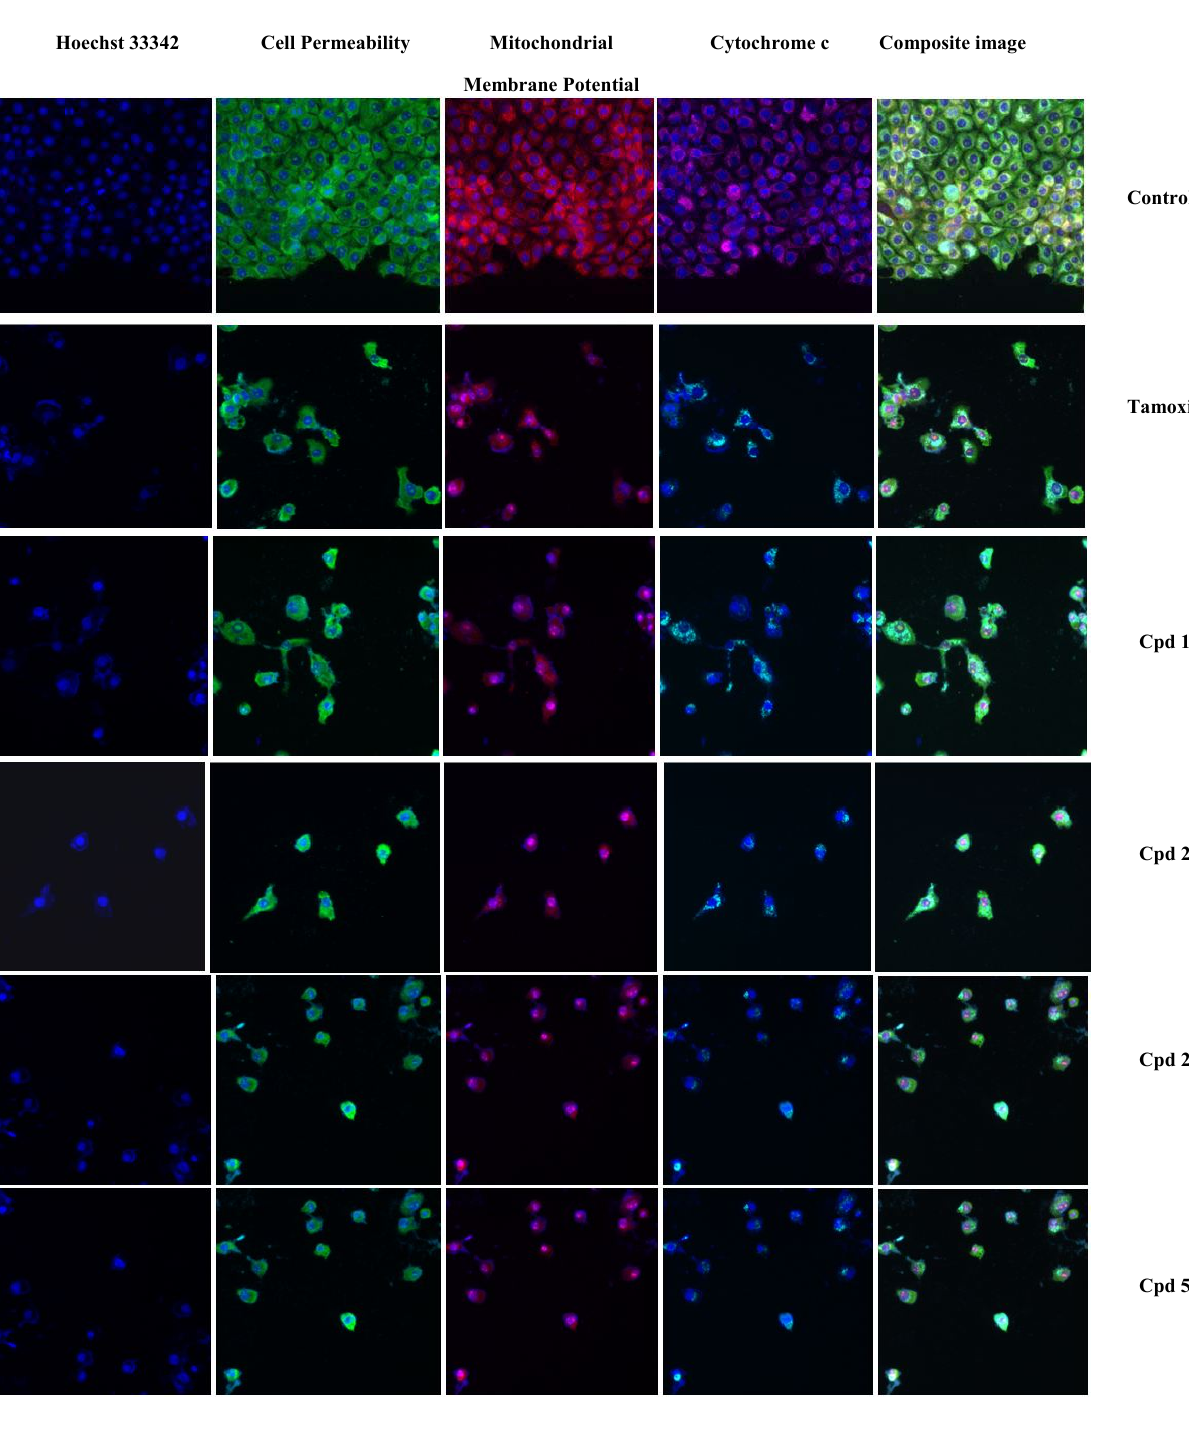
Figure 2. Representative images of MCF7 cells treated with medium alone and compounds, and stained with nuclear staining dye, cell permeability dye, mitochondrial membrane potential dye and cytochrome c. The images from each row are obtained from the same field of the same treatment sample. MCF7 cells produced a marked reduction in mitochondrial membrane potential, and marked increases in membrane permeability and cytochrome c. (Magnification 20X). (1A- 3 µg/mL; 1B- 6 µg/mL), (23A- 3 µg/mL; 23B- 6 µg/mL), (25A- 2 µg/mL; 25B- 4 µg/mL) and (5A- 3 µg/mL; 5B- 6 µg/mL). The positive control used in the analysis was tamoxifen (0.04 µg/mL). “Cpd” refers to